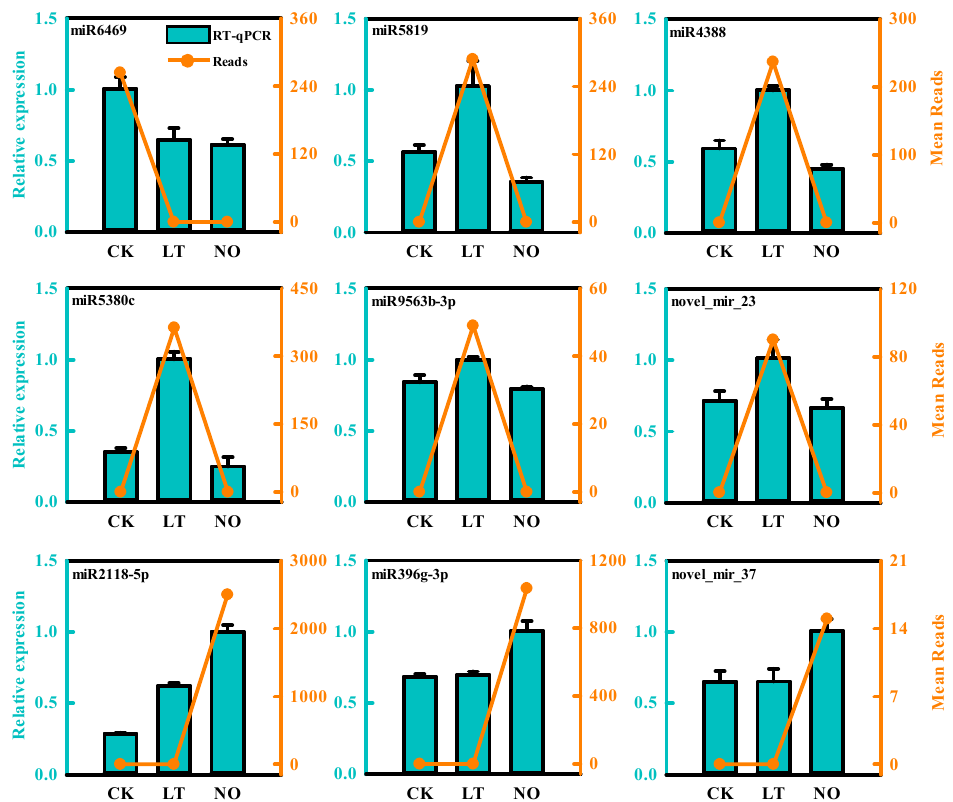
Figure 3. Expression validation of selected microRNAs (DEMs) in CK (control), LT (low-temperature) and NO (nitric oxide) by RT-qPCR. The error bars show standard deviation between biological replicates.